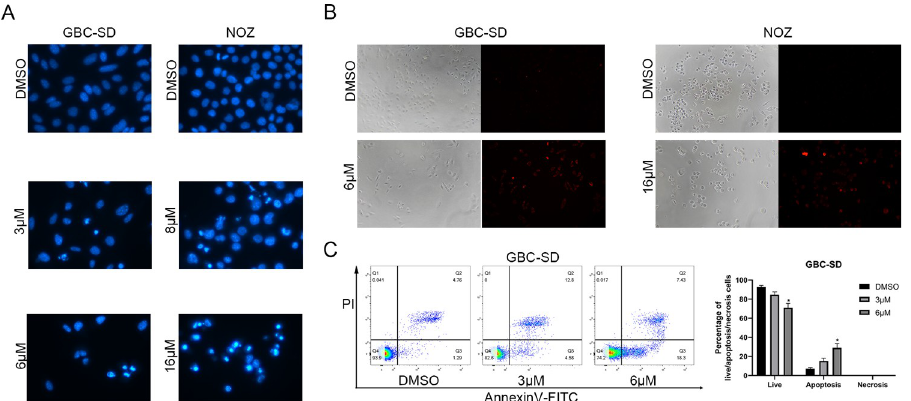
Fig 2. Fangchinoline induces the apoptosis of GBC cells. (A) Hoechst 33258 staining of GBC cells treated with fangchinoline. (B) TUNEL assay of the apoptosis effect of GBC cells with high fangchinoline concentration. (C) Annexin V/ PI apoptosis assay of GBC-SD. Annexin V (+)/PI ( − ) or Annexin V ( − )/PI (+) were considered as apoptotic cells, Annexin V ( − )/PI ( − ) cells were alive, and Annexin V (+)/PI (+) cells were necrotic.